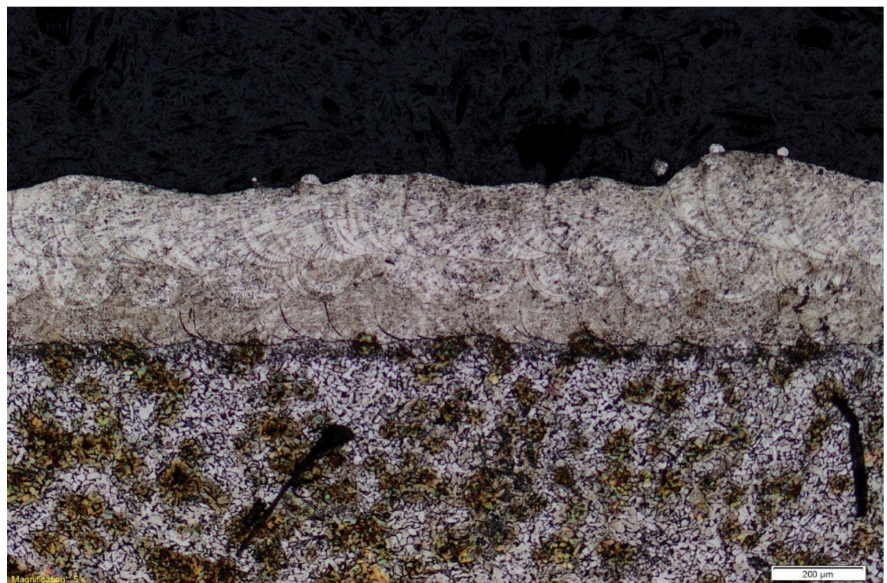
Figure 13. Microstructure of the deposited layers of steel PR-12H18N9T with a hatch distance along X-Y = 0.22 mm, and along Z = 0.2 mm.